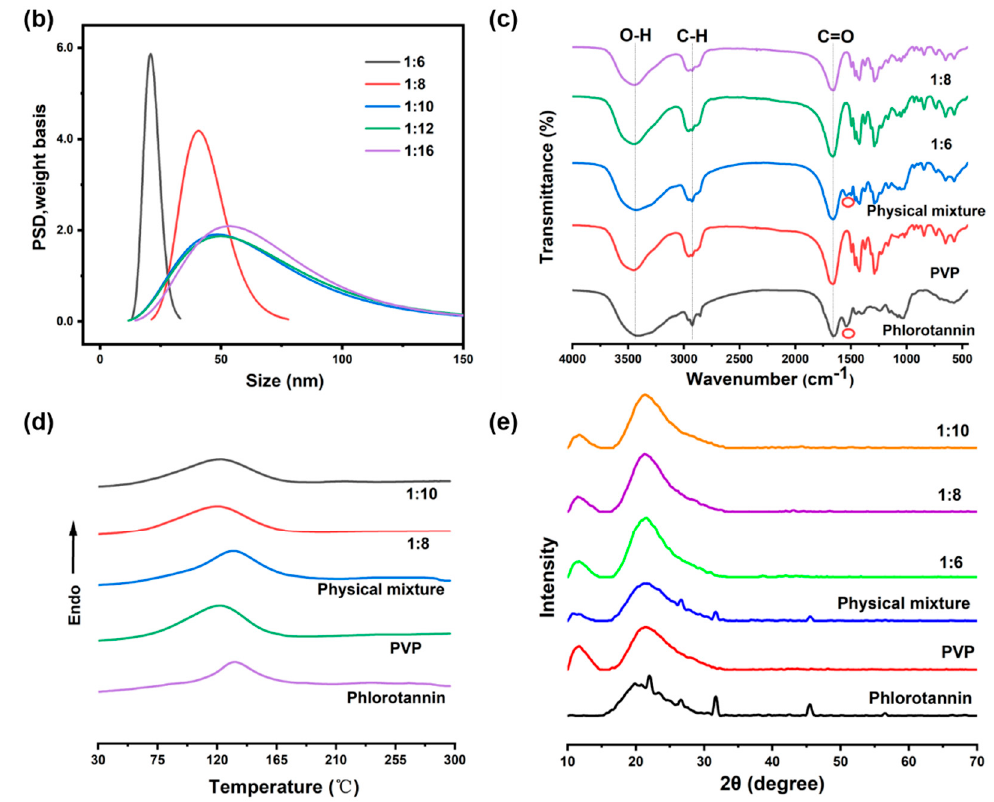
Figure 1. Characterization of PPNPS (polyvinylpyrrolidone nanoparticles): ( a ) Images of PPNPS with different loading ratios; ( b ) Particle size distribution (the concentration of PPNPS was 10 mg/mL in solution); ( c ) FTIR spectra (the samples were solid); ( d ) DSC (differential scanning calorimetry) thermograms (the samples were solid) and ( e ) X-ray diffraction patterns (the samples were solid).